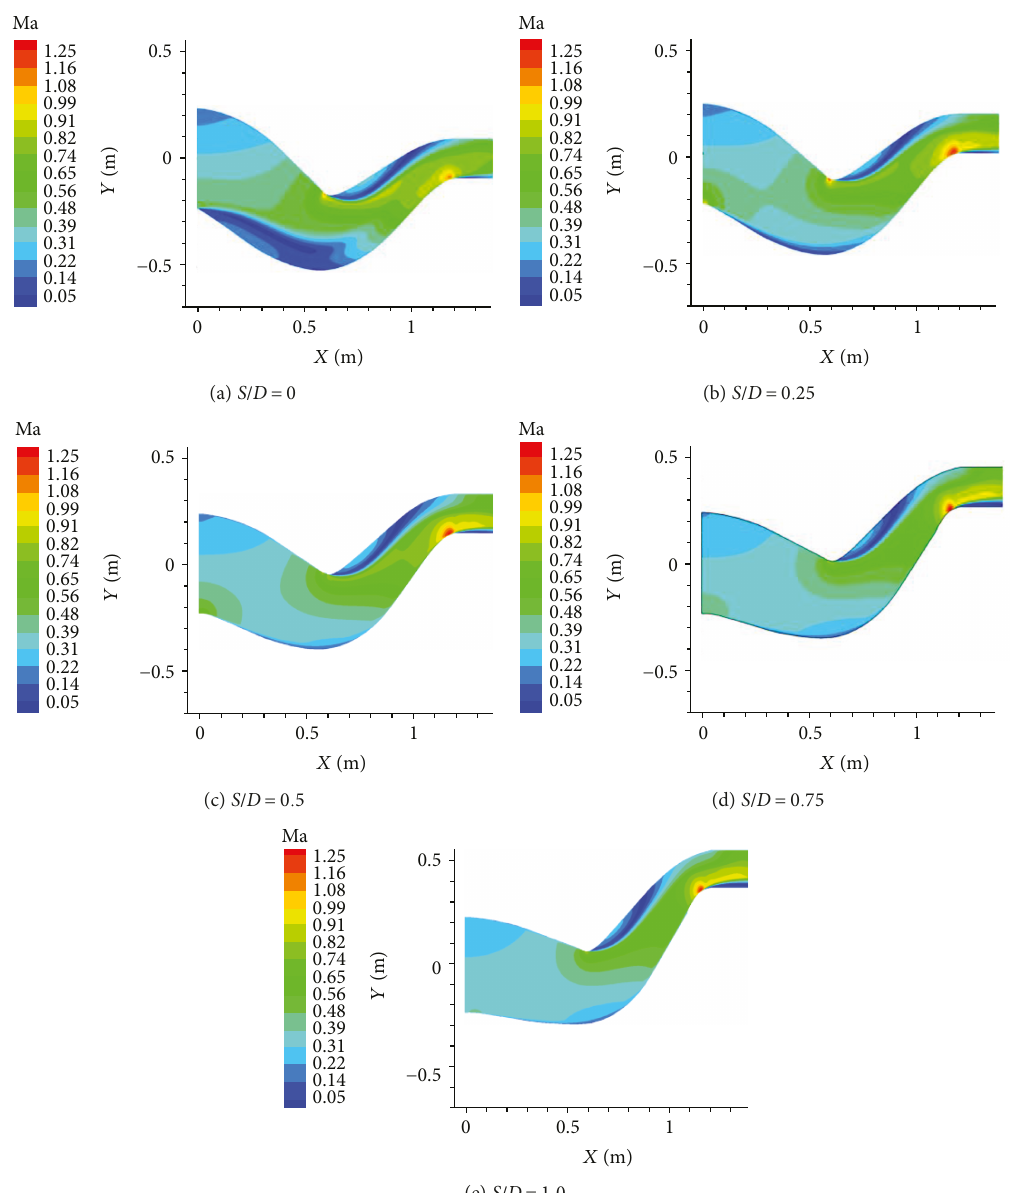
Figure 11: Ma number distributions on symmetric plane ( W / H = 3 3 , L / D = 3